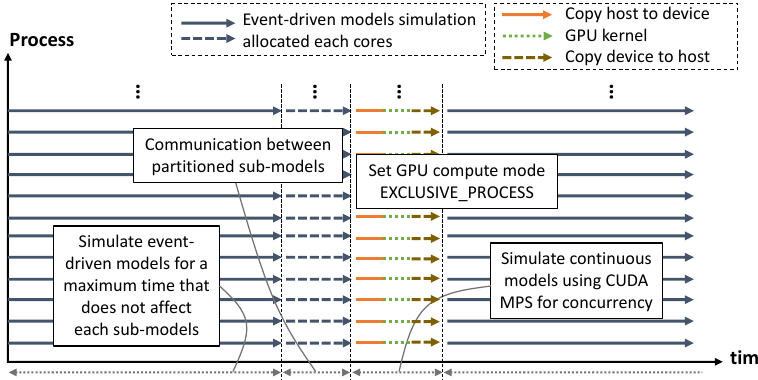
Figure 4. Idea of using GPU in hybrid system